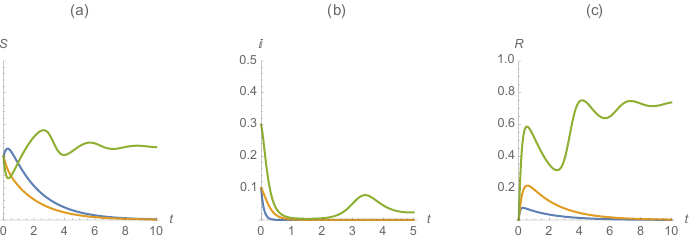
Figure 4. ( a ) S j , ( b ) I j , and ( c ) R j . The first disease is represented in blue, the second in orange and those susceptible/infected/recovered by diseases in